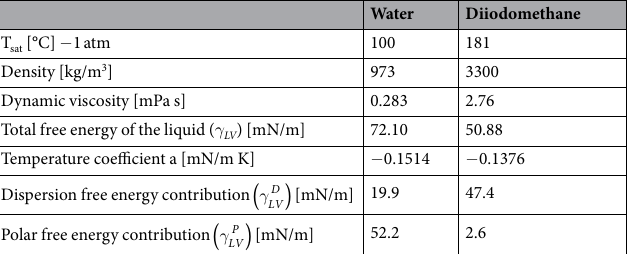
Table 2. Physical properties of the liquids. T sat is the boiling temperature (at 1 atm). Surface tension, density and dynamic viscosity are evaluated at T amb = 20 °C 34 .